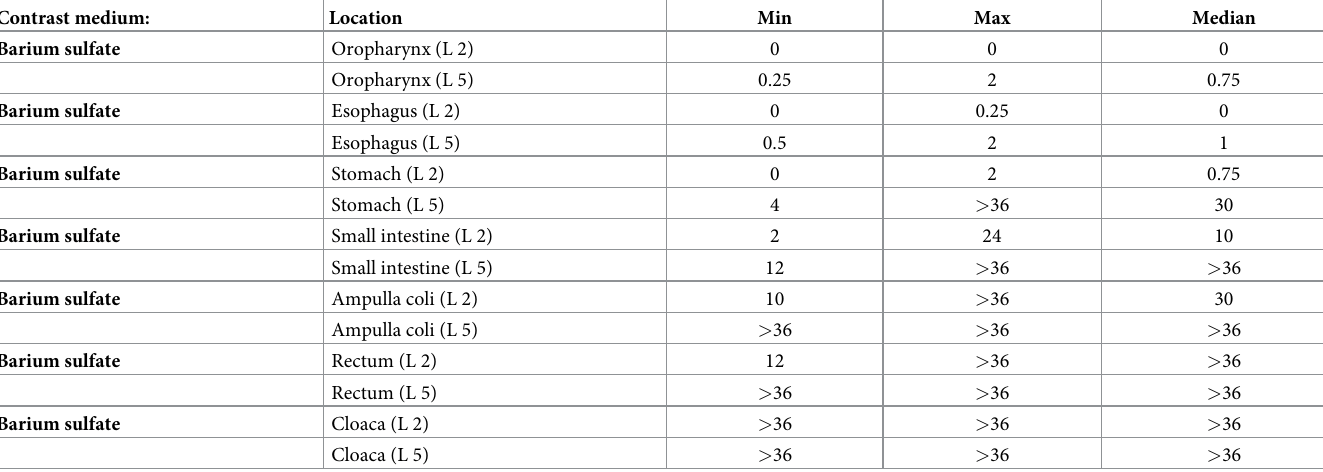
(Fig 9). Longitudinal folds could be seen in the stomach with BaSO in four out of five animals. 4 BaSO completely filled the stomach within two hours in all five animals, and complete empty- 4 ing time was 4, 10, 30 and 36 hours and even more than 36 hours in one animal. This bearded dragon maintained BaSO in the stomach for the entire 36 hours study (Tables 4 and 5). In all 4 five bearded dragons, stomach contrast lasted from 15 minutes to over 36 hours (Fig 10). Fig 10 illustrates the time that BaSO was found in the stomach of the five bearded dragons. 4 Table 5. Course of contrast study (in hours), displaying type of contrast medium (barium sulfate). Summary of BaSO 4 group of Table 4. Contrast